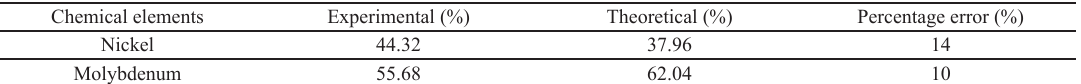
by EDX (%) calcined at 800 °C. 4